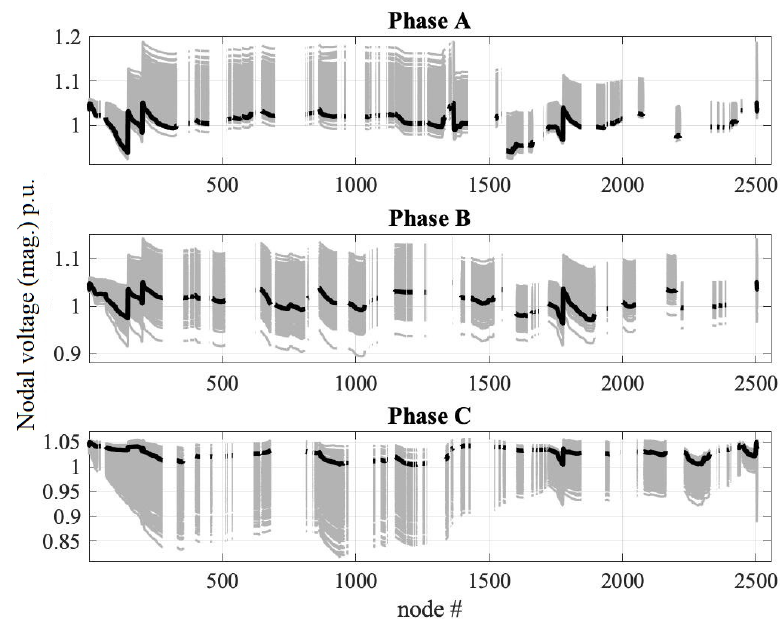
Figure 5. Overall voltage profile of the network generated by considering a subset of 1000 Monte Carlo simulations (gray curves). The solid black curves correspond to the nominal network response.